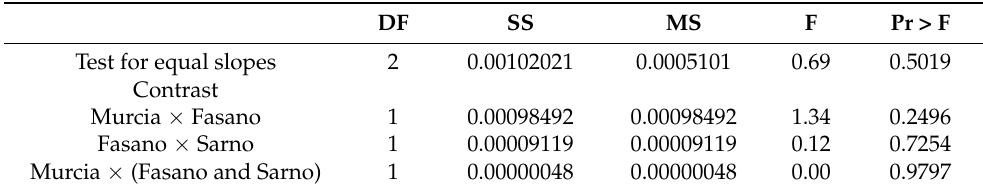
Table 4. Results of the overall test of equal slope and of the contrast analysis for regression coefficient